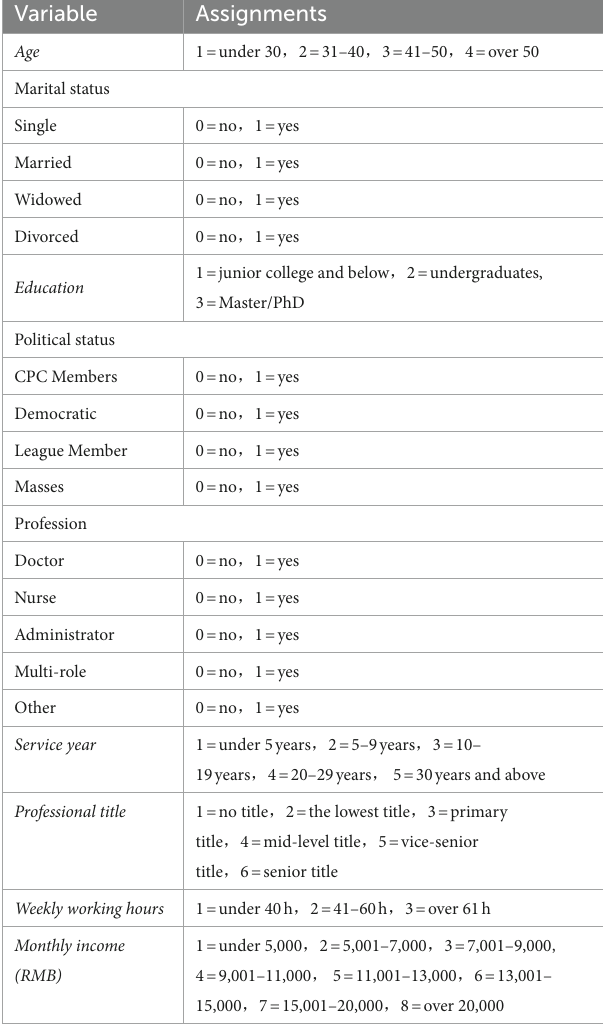
TABLE 3 Variable